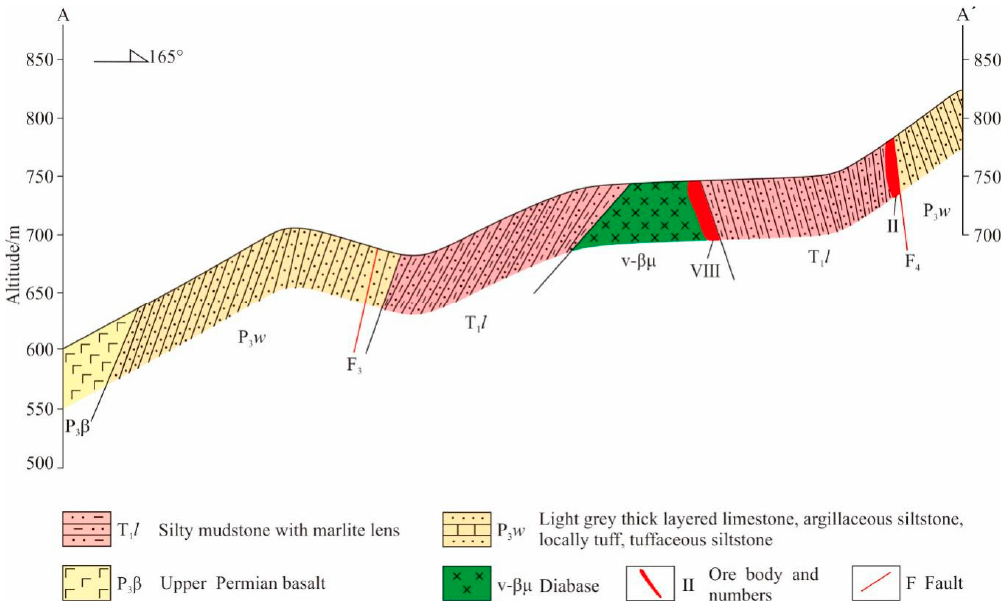
Figure 3. Regional geological cross section of the Zhesang gold deposit.